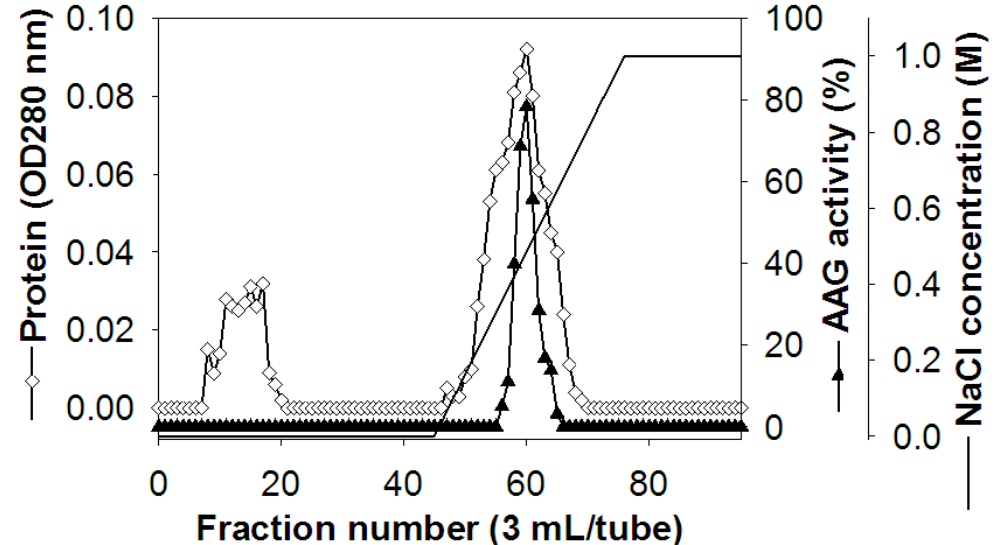
Figure 1. Elution profile of TKU004P on Macro-Prep High S chromatography.